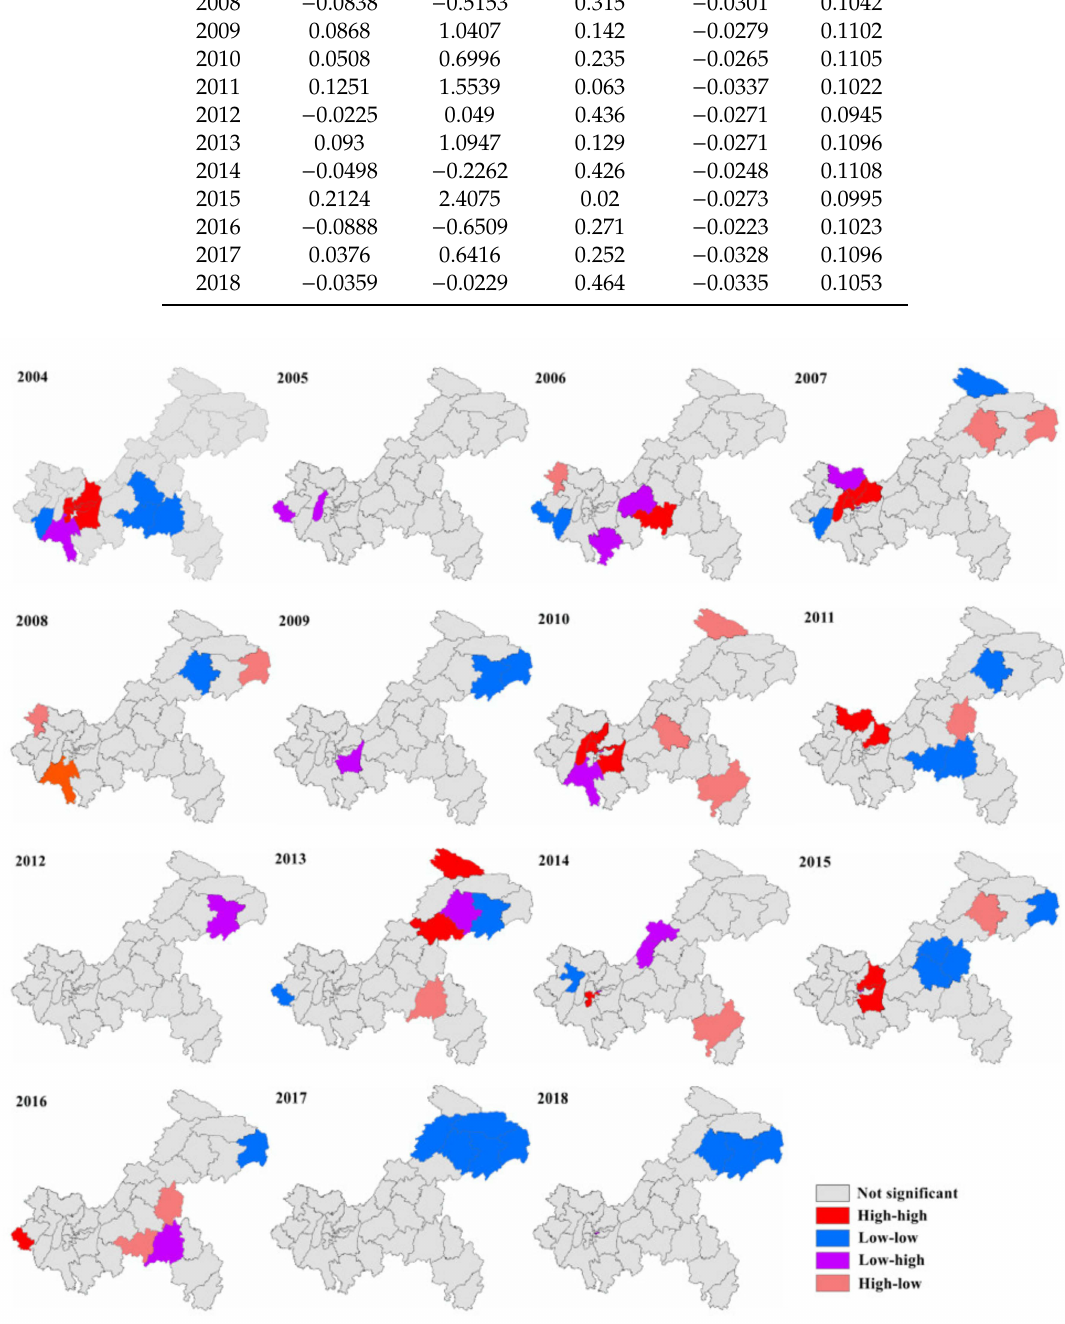
Figure 4. Yearly local spatial autocorrelation of mumps in Chongqing from 2004 to